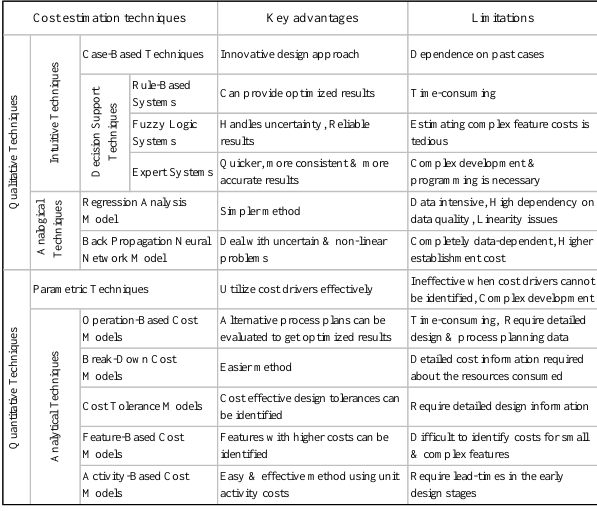
Fig. 4: Key advantages and limitations of the cost estimation techniques, adapted from [3,6]